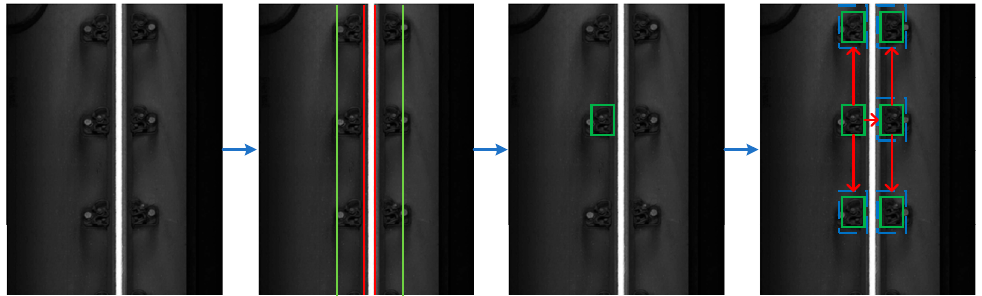
Figure 4. Fastener area positioning results.